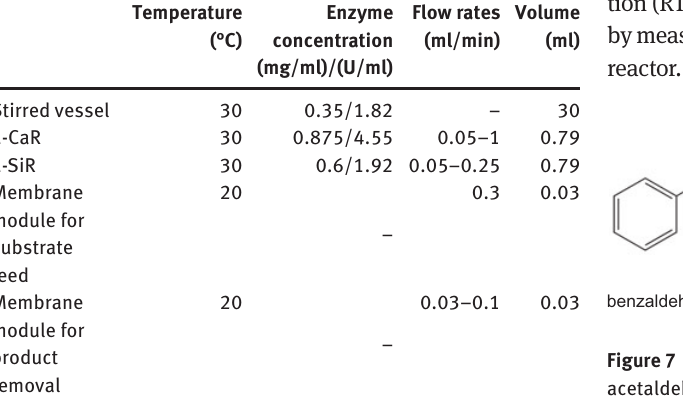
Table 1 Reaction conditions for stirred vessel, flow reactors and membrane